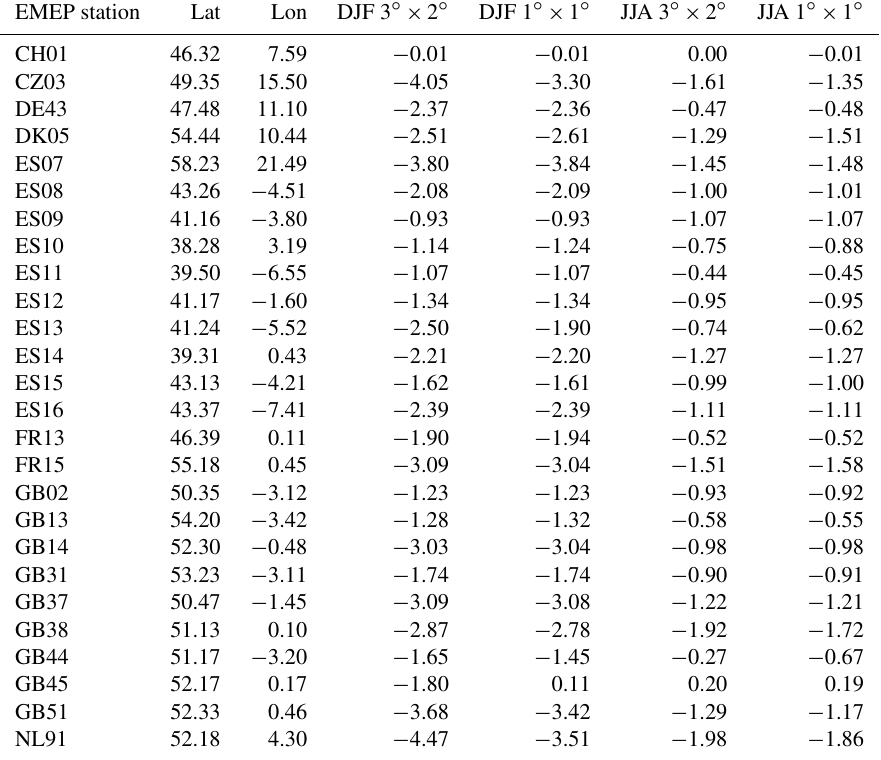
Table 6. The seasonal mean absolute biases as calculated using weekly [NO] values (µgm − 3 ) . The weekly means are composed from daily measurements taken at 13:00 for DJF and JJA (given as the difference in the measurements–model). Values are shown for both the 3 ◦ × 2 ◦ and 1 ◦ × 1 ◦ simulations for all stations with available data. Those with differences < 5% are considered to exhibit no discernible change in the